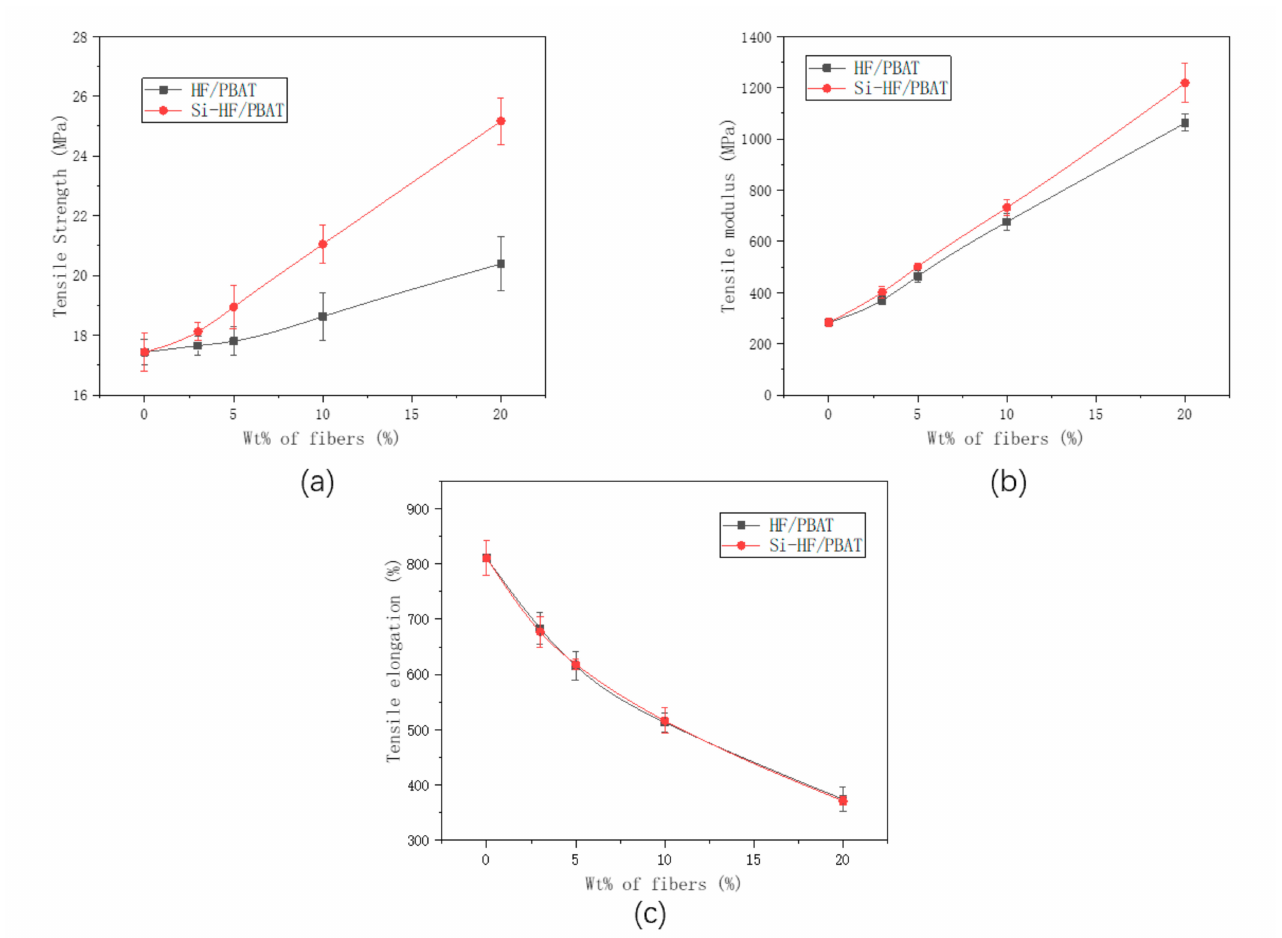
Figure 3. Tensile properties of neat PBAT and its composites ( a ) Tensile strength of hemp and Si-hemp, ( b ) Tensile modulus of hemp and Si-hemp, ( c ) Tensile elongation of hemp and